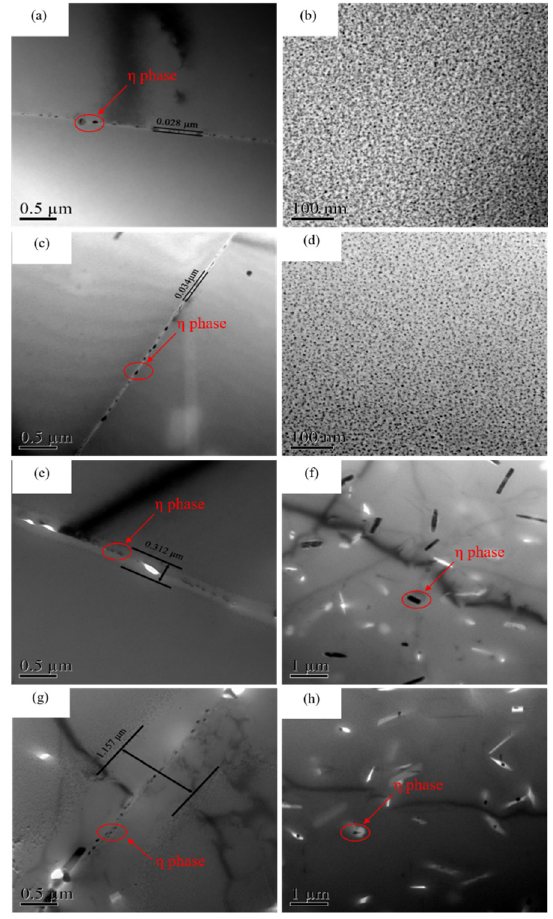
Figure 4. TEM images of DA and 295 °C isothermal quenched samples: ( a , b ) DA; ( c , d ) 100 s; ( e , f ) 800 s; ( g , h ) 1500 s.